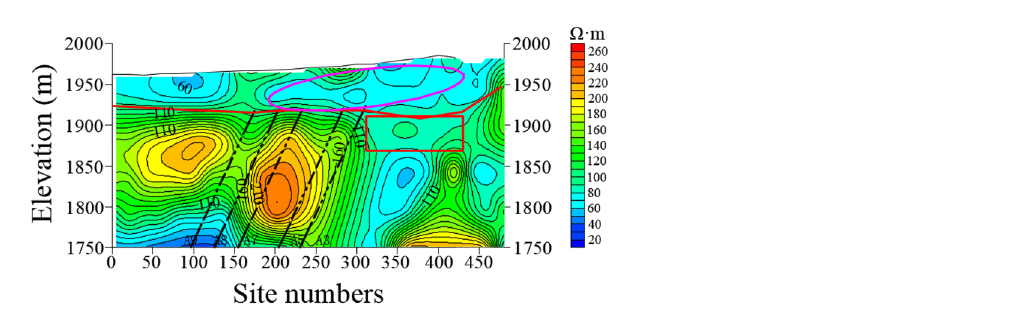
Figure 8. Drill column of geological prospecting boreholes. ( a ) 3–1 borehole, ( b ) 3–2 borehole.